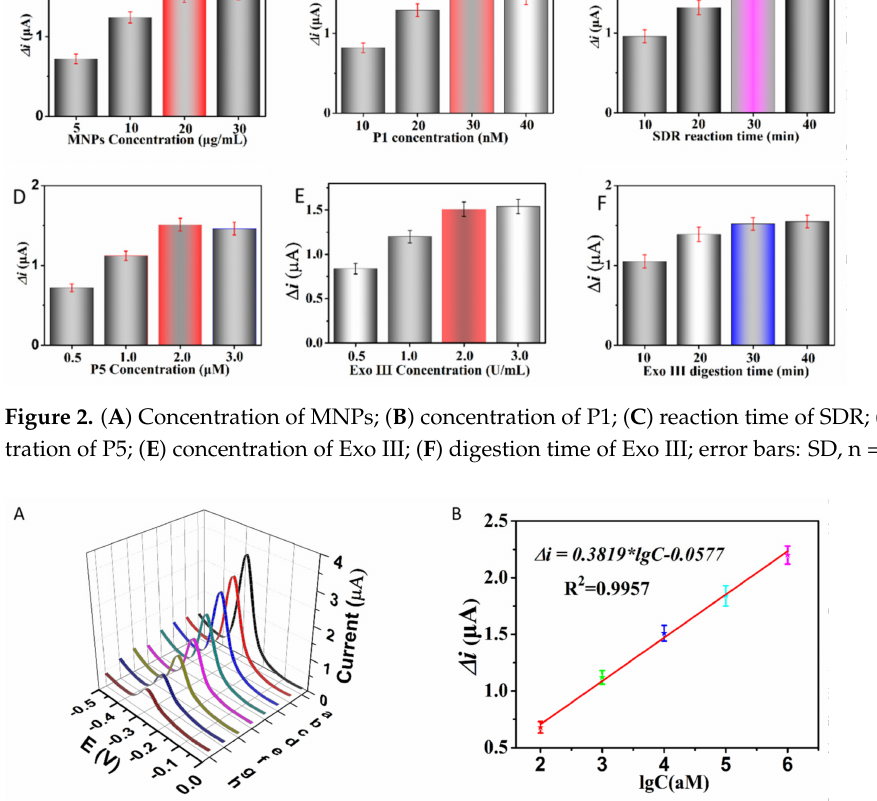
Figure 3. ( A ): The corresponding DPV current response of a series of concentrations of miR-145 (a, blank; b, 10 aM; c, 100 aM; d, 1 × 10 3 aM; e, 1 × 10 4 aM; f, 1 × 10 5 aM; g, 1 × 10 6 aM; h, 1 × 10 7 aM); ( B ): the linear correlation between the change in electrochemical signal intensity and the constant logarithm of the concentration of miR-145 (C is the concentration of miR-145, aM). Error bars: SD, n =